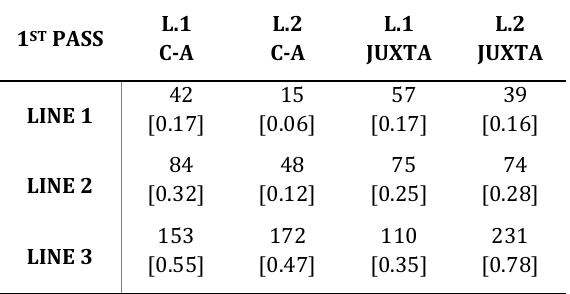
Table 2B. First-pass dwell times (per word) following